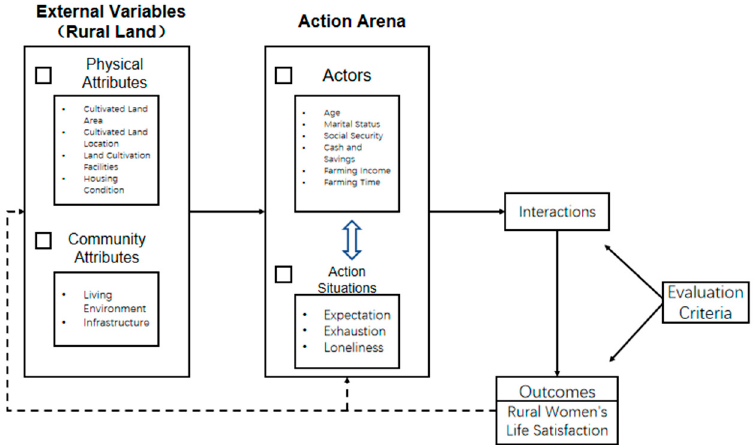
Figure 1. An IAD analytical framework for life satisfaction of rural women farmers. Source: authors’ own construction.